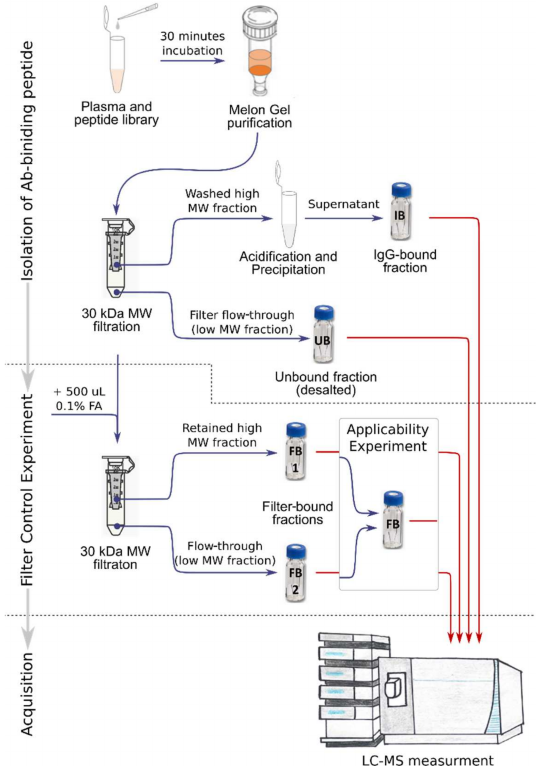
Figure 1. Flowchart of the antibody–peptide binding assay. IgG-bound fraction (IB), unbound fraction (UB) and filter-bound fraction (FB) annotated on LC vials are described in the text. In the feasibility experiment, two filter-bound fractions (high- and low-MW fractions) were collected and analyzed separately. In the applicability experiment, filter-bound fractions FB1 and FB2 were taken together as one filter-bound fraction (FB).